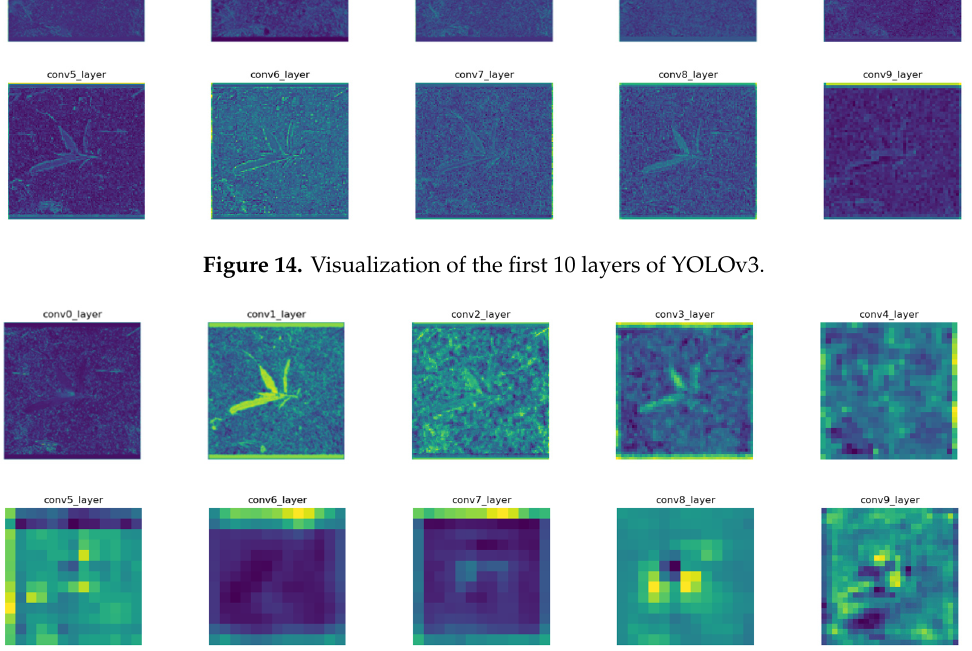
Figure 15. Visualization of the first 10 layers of YOLOv3_tiny .